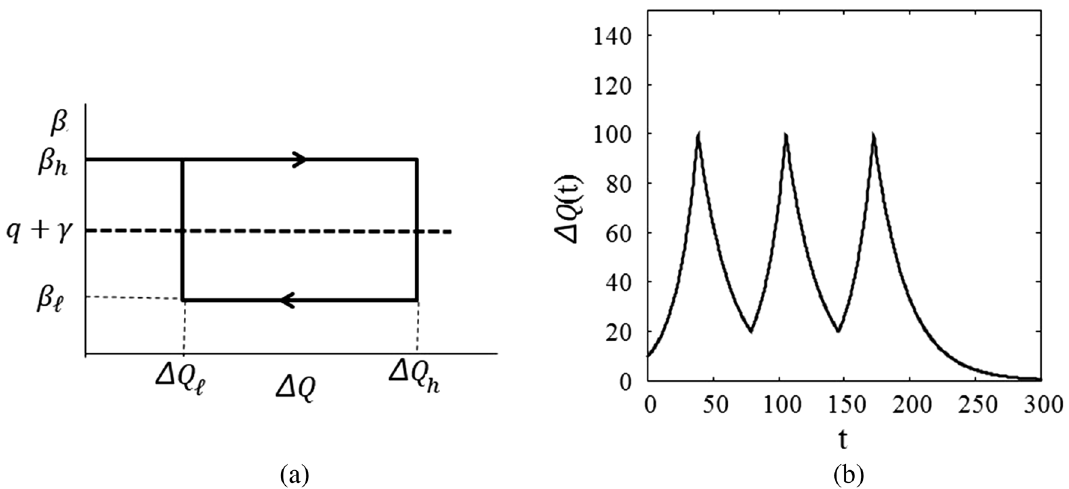
Figure 3. (a) Model transmission coefficient depending on (cid:31) Q and d � Q ( t )/ dt . (b) Wavy infection curve for the model transmission